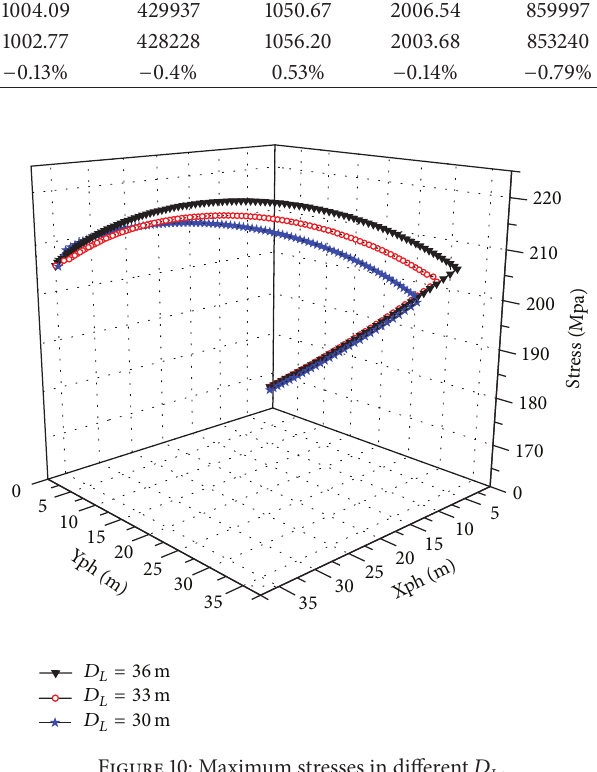
Figure 10: Maximum stresses in different 𝐷 𝐿